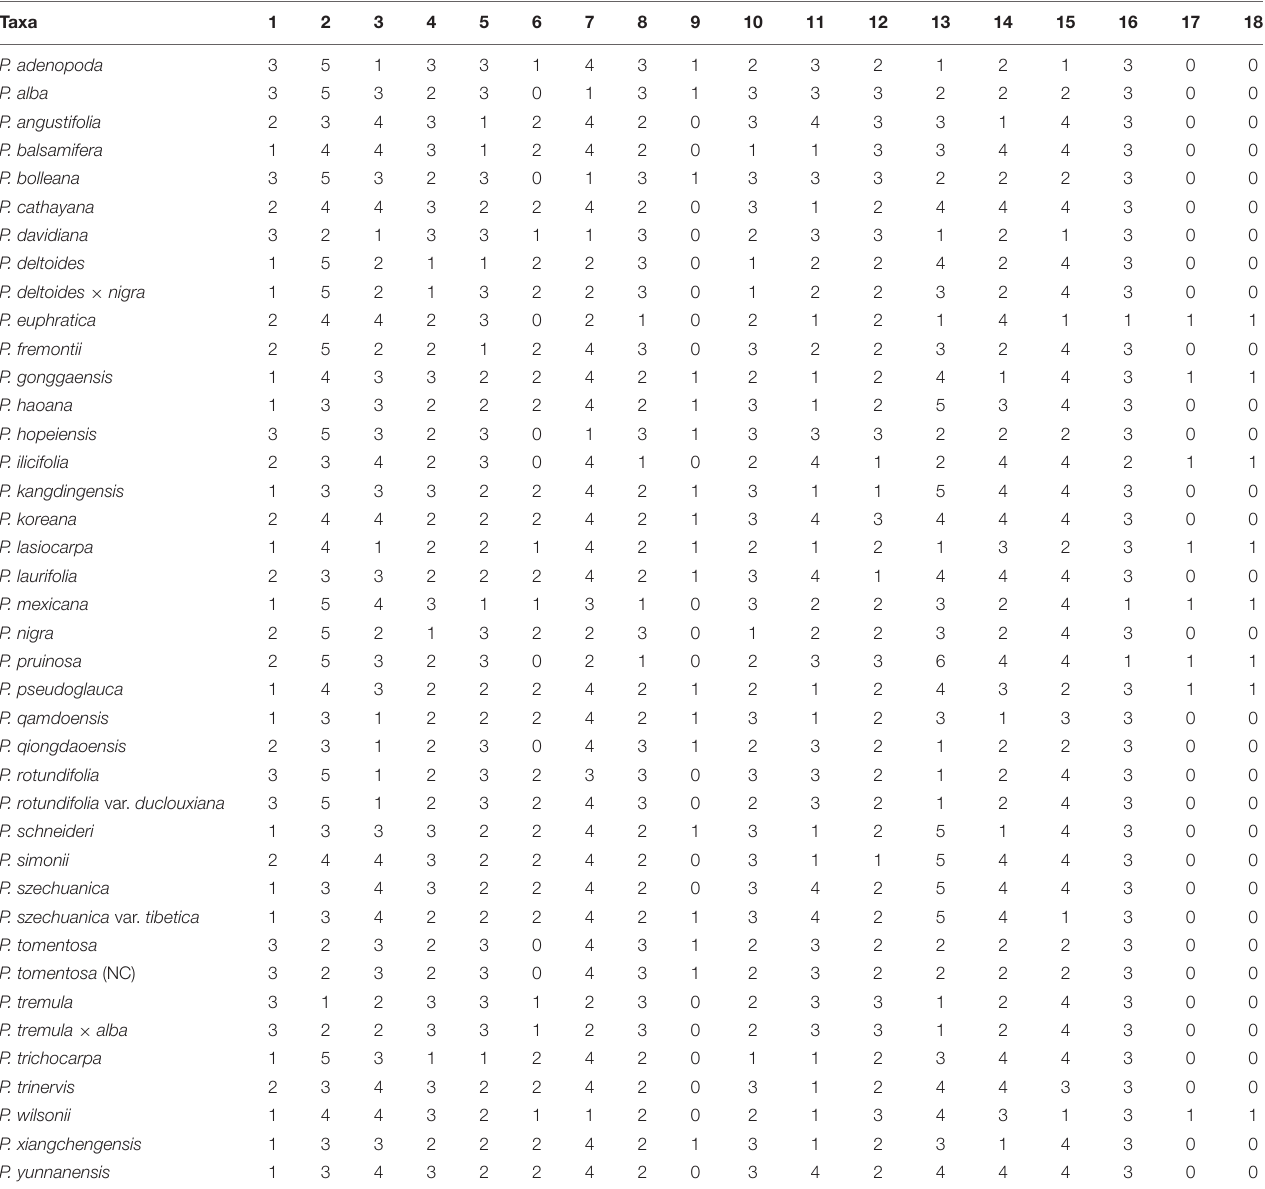
TABLE 3 | Data matrix of morphological characters in the